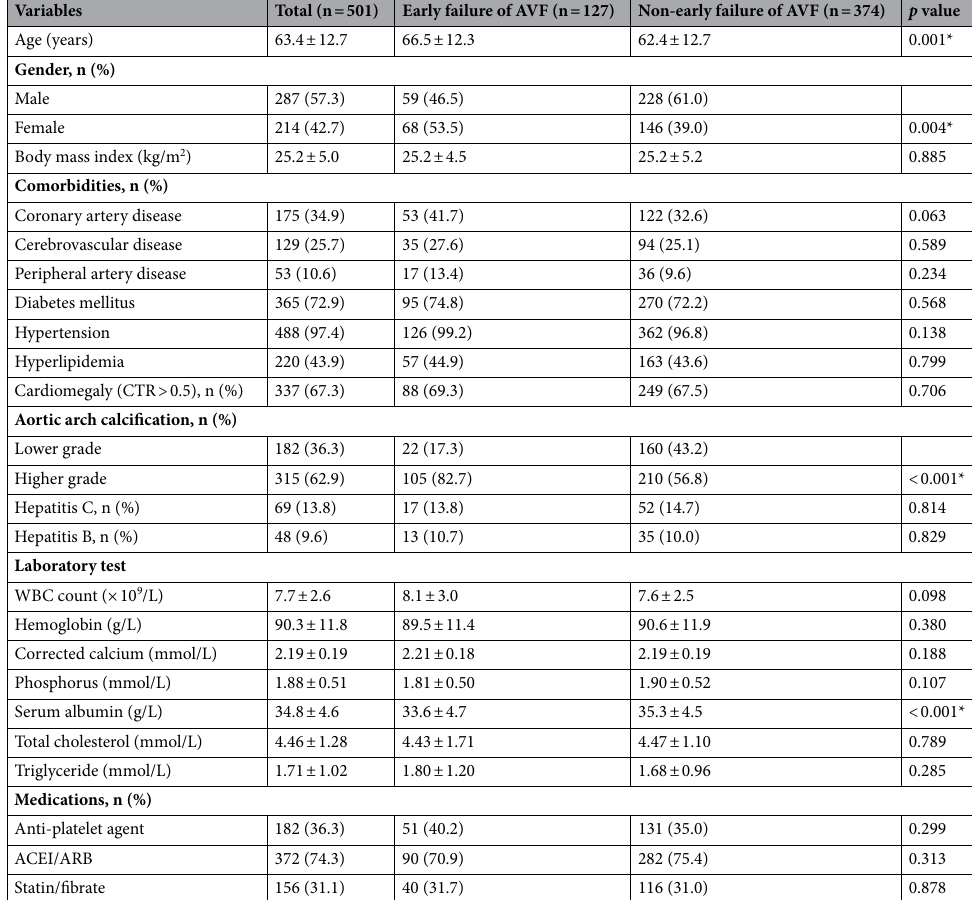
WBC white blood cell, ACEI angiotensin converting enzyme inhibitor, ARB angiotensin receptor blocker. *p <